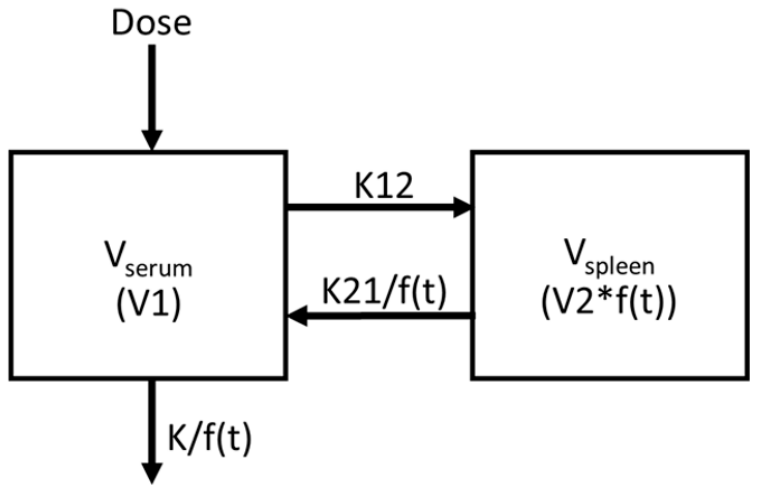
Figure 1. The previously published 2-compartment, context-dependent pharmacokinetic model [1] using the RSR expansion function as f(t).